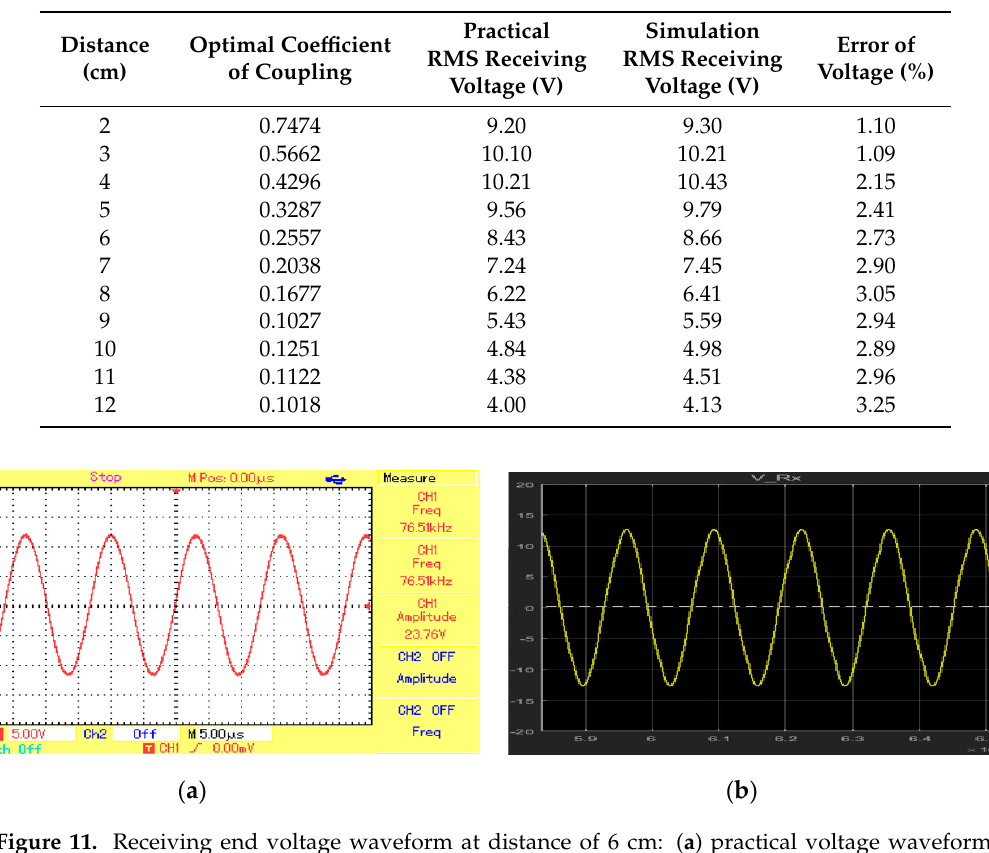
Table 4. Comparison between practical and simulation receiving RMS voltage.